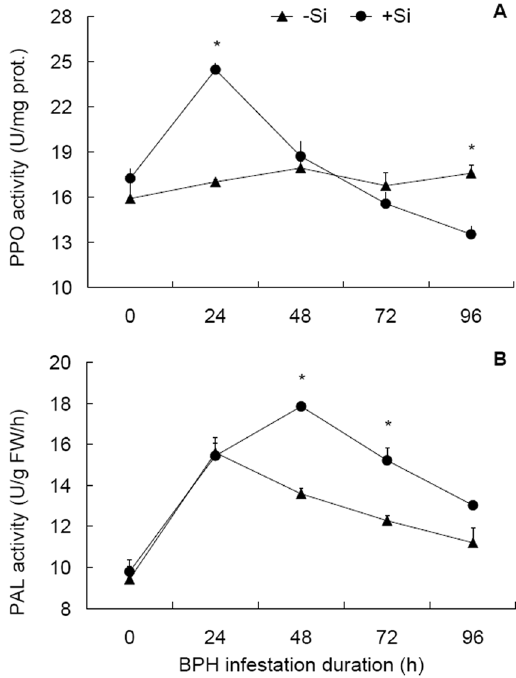
Figure 3. Activities of enzymes for production of secondary metabolites in rice sheaths in response to Si amendment and BPH infestation. ( A ) Polyphenol oxidase, PPO. ( B ) Pheny-lalanine ammonia-lyase, PAL. + Si = silicon amendment to rice plants at 112 mg Si/kg nutrient solution, − Si = no silicon amendment. Error bars represent 1 × SE. n = 3 (biological replicates). * Significant difference between + Si and − Si plants at a certain time post BPH infestation at P < 0.05 via independent samples T test.